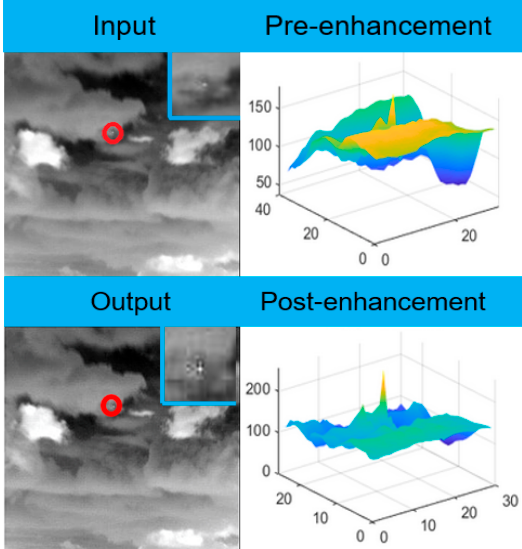
Figure 2. 3D visualisation results for the target before and after enhancement.